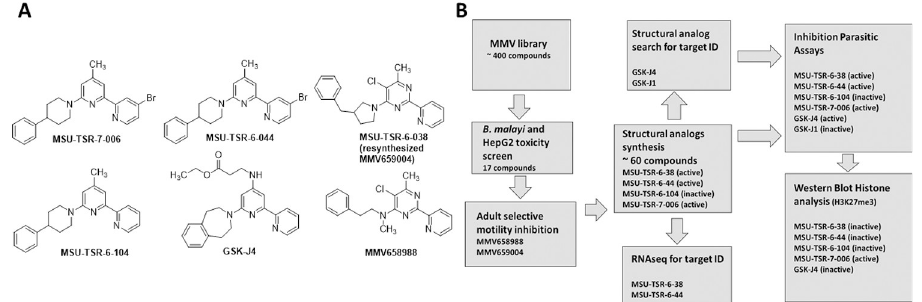
Fig 1. (A) Compounds identified, synthesized and tested for inhibition of parasite motility. (B) Flow diagram illustrating screening, synthesis and evaluation of compounds.